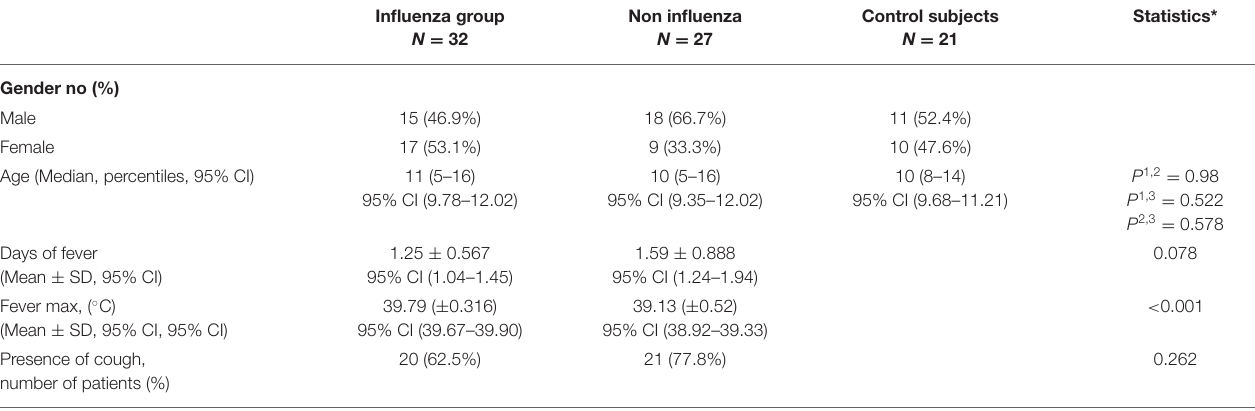
TABLE 1 | Demographic and clinical characteristics of children attending the emergency department with respiratory symptoms and healthy control